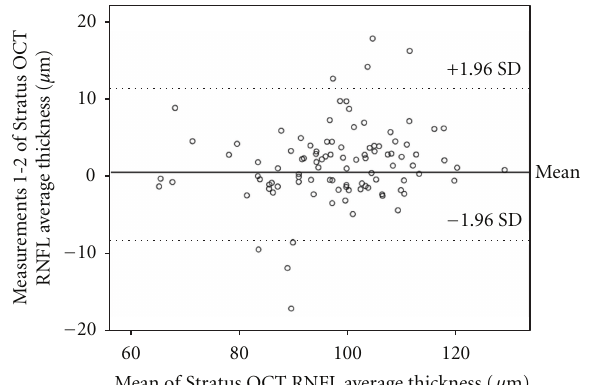
Figure 3: Bland-Altman plots of the agreement in retinal nerve fiber layer (RNFL) thickness between Stratus OCT measurement 1 and measurement 2. The di ff erence (Stratus OCT average RNFL thickness measurement 1 minus Stratus OCT average RNFL thickness measurement 2) was plotted against the average of the three measurements for the average RNFL thickness Stratus OCT measurements. SD: standard deviation.